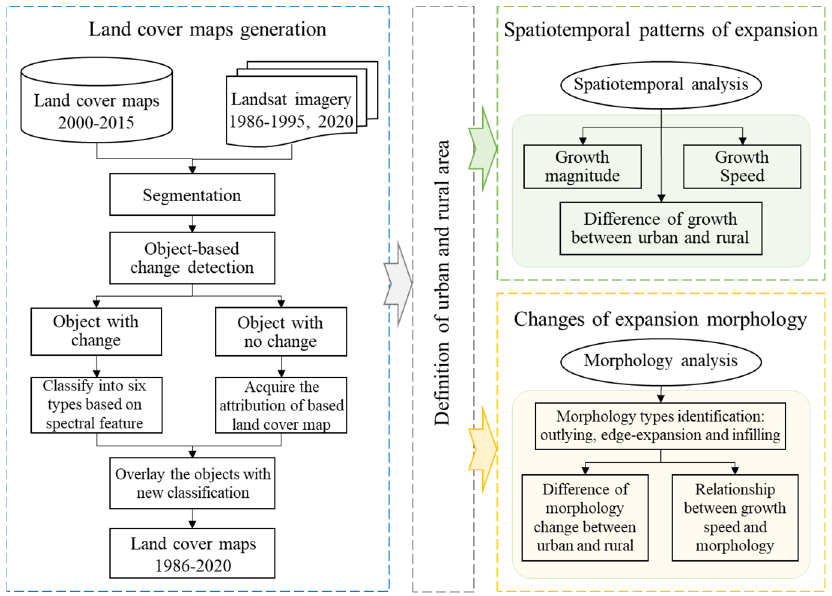
Figure 3. Flowchart for the dynamic process of developed land between urban and rural areas.